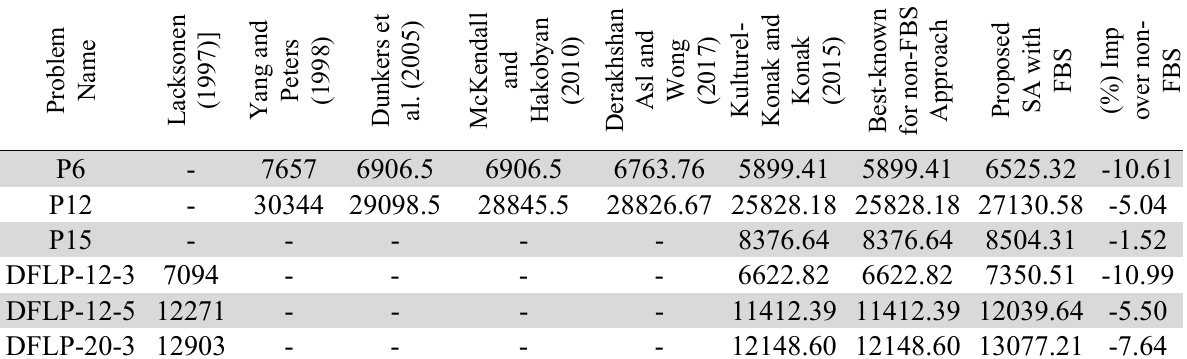
Planning horizon cost comparison of proposed FBS based SA heuristic with other non-FBS based approaches reported in the literature for UA-DFLPs